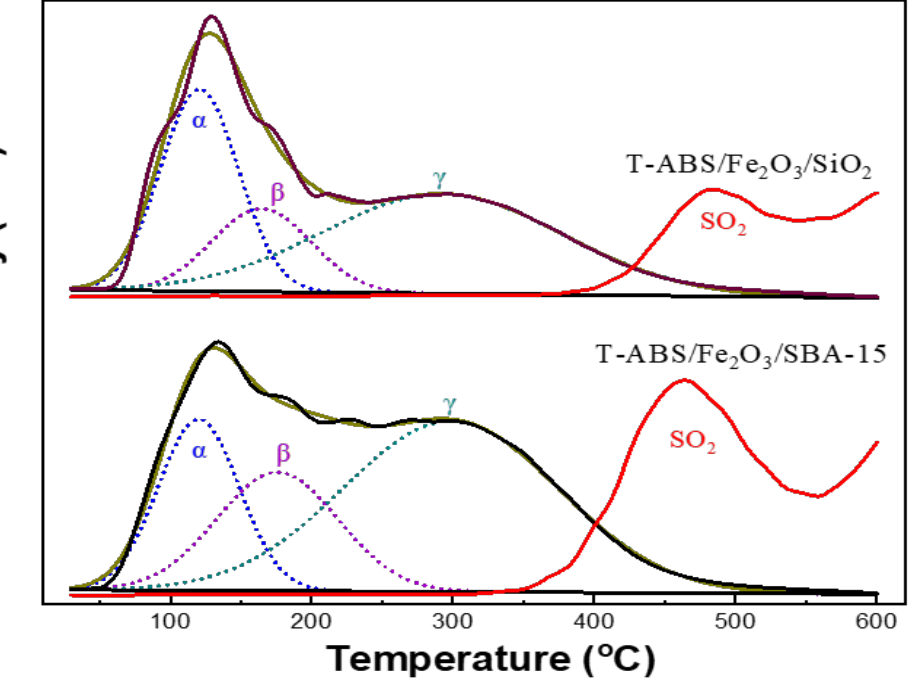
Figure 5. NH 3 -TPD profiles of the treated samples.